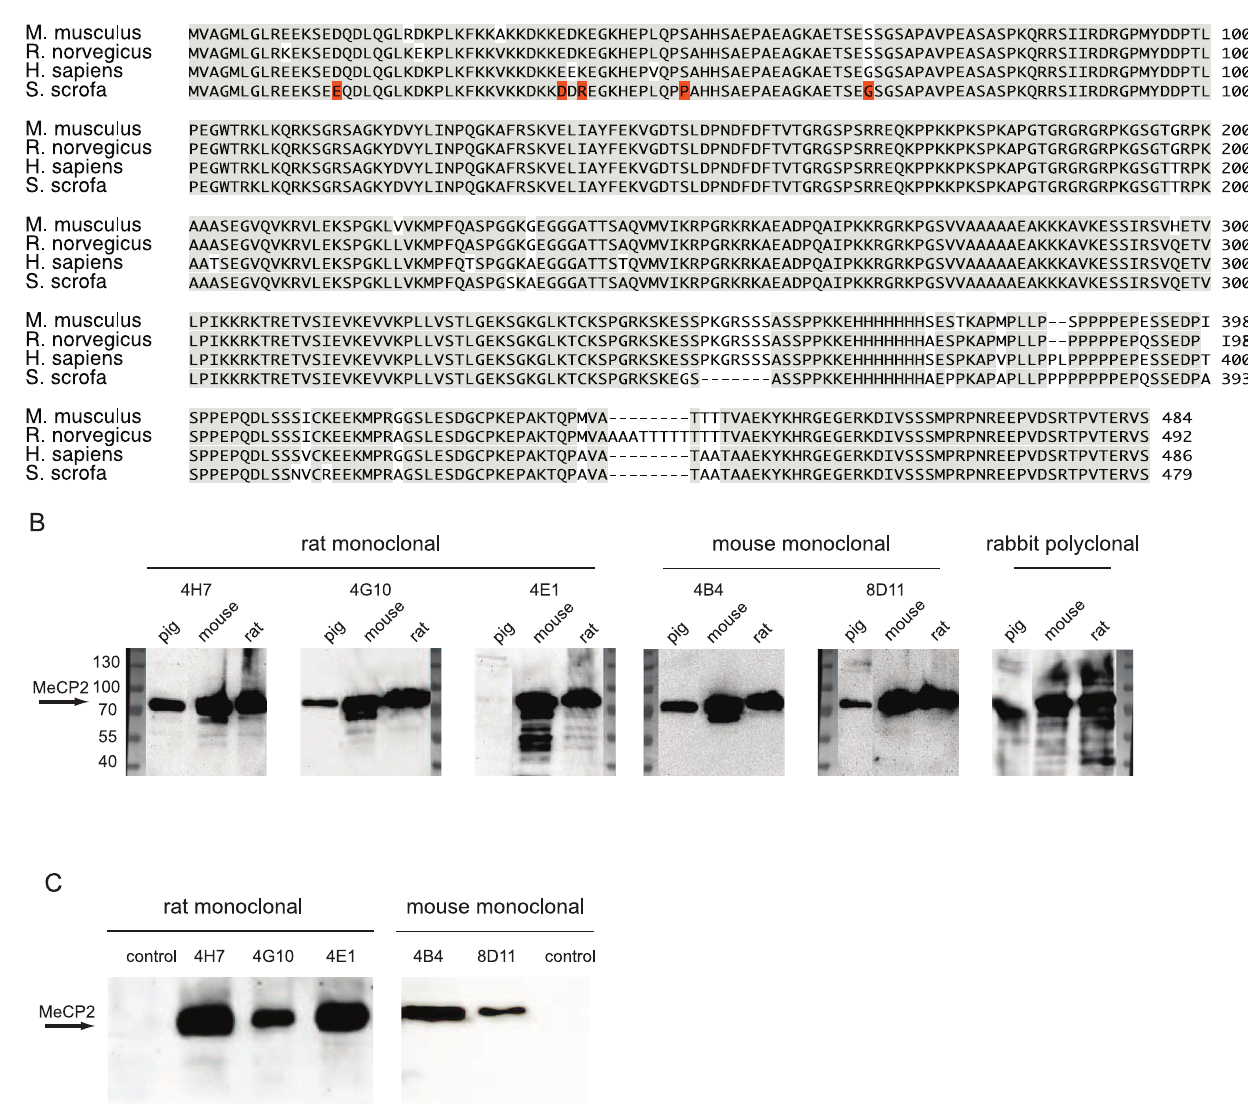
Figure 4. Antibody specificity. A ) Sequence alignment of MeCP2 from different species. Identical residues are shaded in gray. The identities range from 93% (human-mouse) to 97% (rat-mouse). B ) For a multi-species immunoblot nuclear extracts from pig, mouse and rat brain (10 6 nuclei) were loaded and probed with the antibodies as indicated. C ) For immunoprecipitation analysis, mouse brain whole cell (for rat antibodies) and nuclei (for mouse antibodies) extracts were incubated with the monoclonal antibodies as indicated followed by western blot analysis.